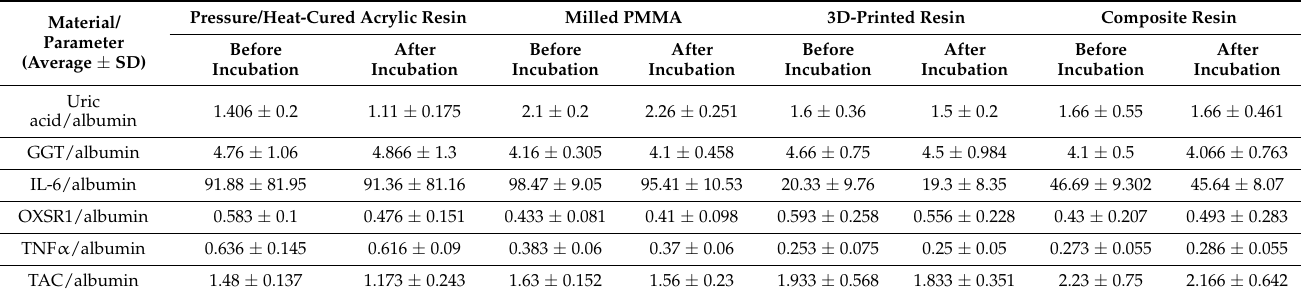
Table 1. Average value of the biochemical parameters for each material type.